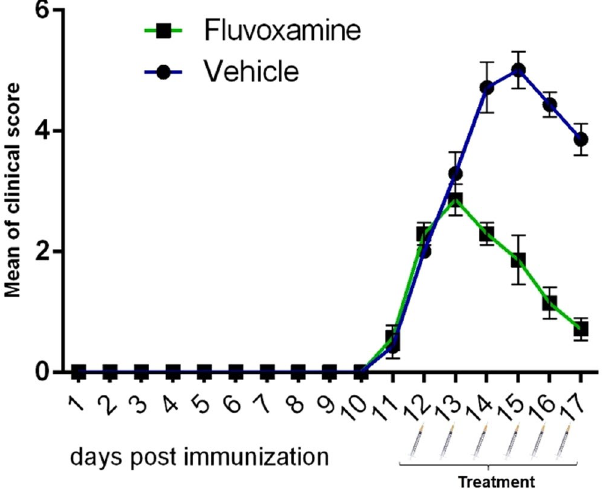
Figure 6. Administration of fluvoxamine ameliorated experimental autoimmune encephalomyelitis (EAE) clinical outcomes. EAE was induced in Lewis rats (day 0) which were treated at day 12 (scores > 2) with fluvoxamine (50 mg/kg) i.p. for 6 subsequent days. Daily clinical scores were measured from day 10 to day 17 in fluvoxamine and vehicle groups. Each group contained 7 rats. Data are expressed as mean ±